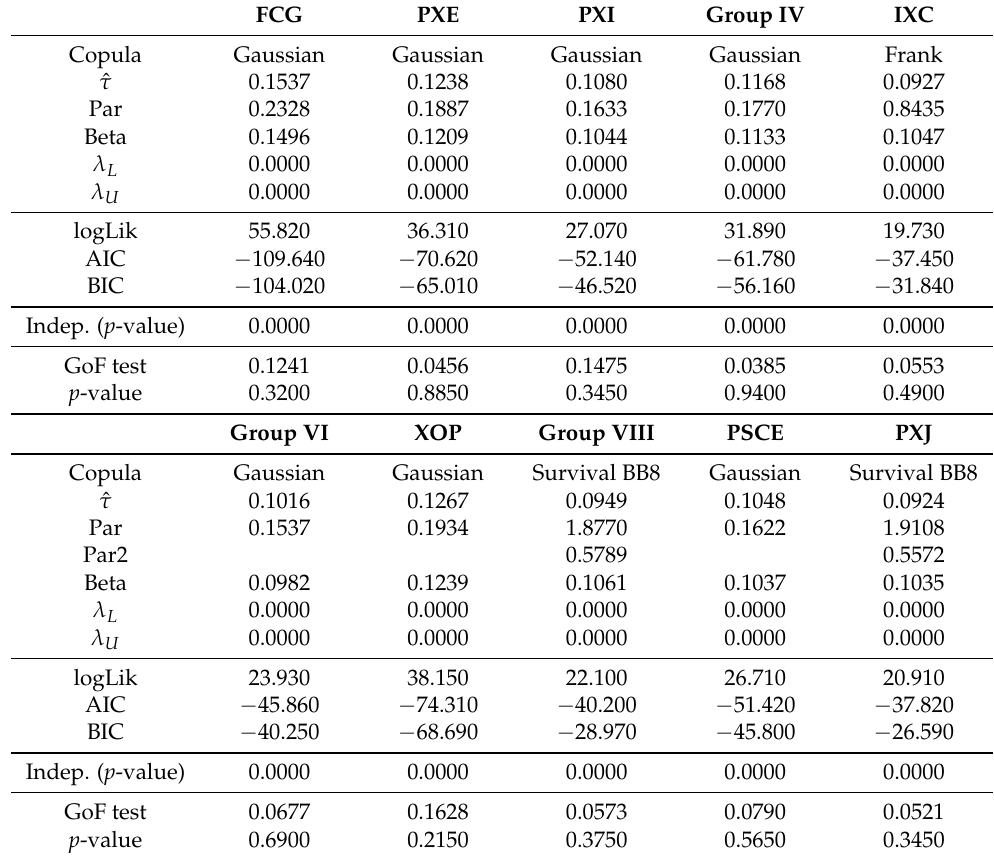
Table 5. Dependence structure for Gas and single